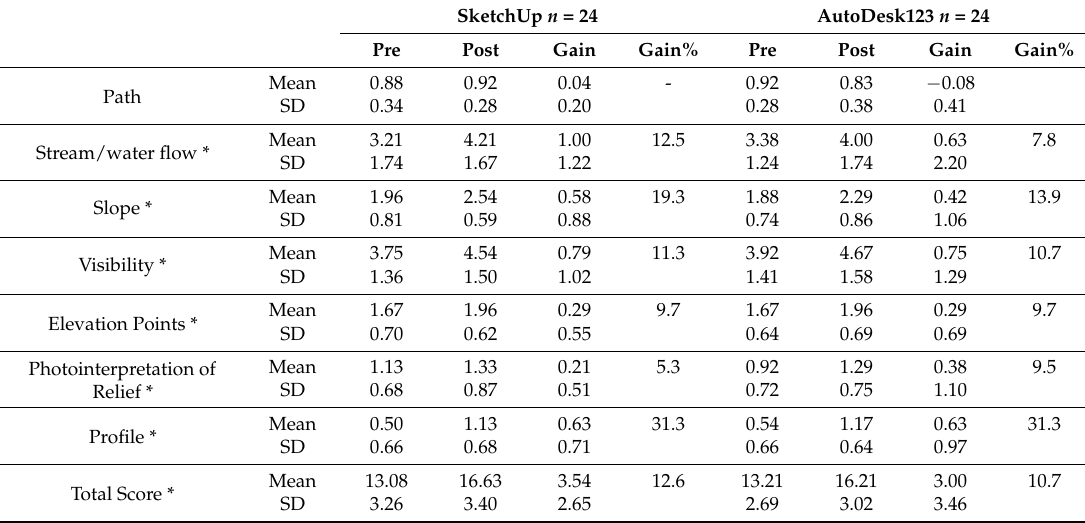
Table 2. Topographic Map Assessment (TMA) means and standard deviations by group (SketchUp and Autodesk123) in the Pre- and Post-tests, along with the